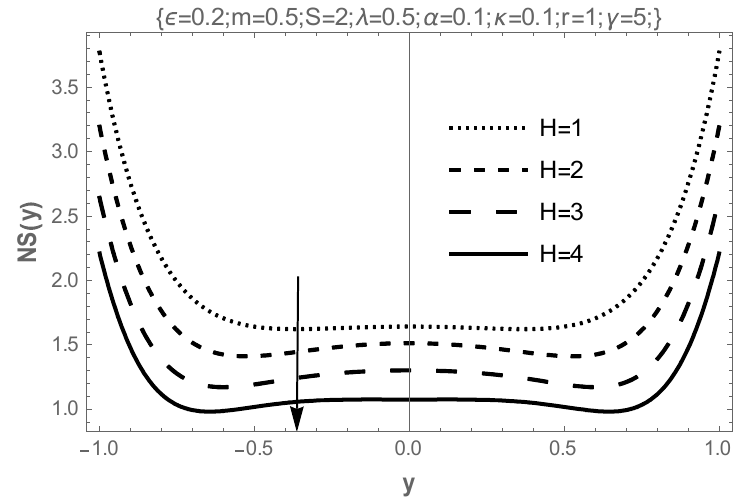
Figure 11. Effect of Hartmann number on fluid temperature.